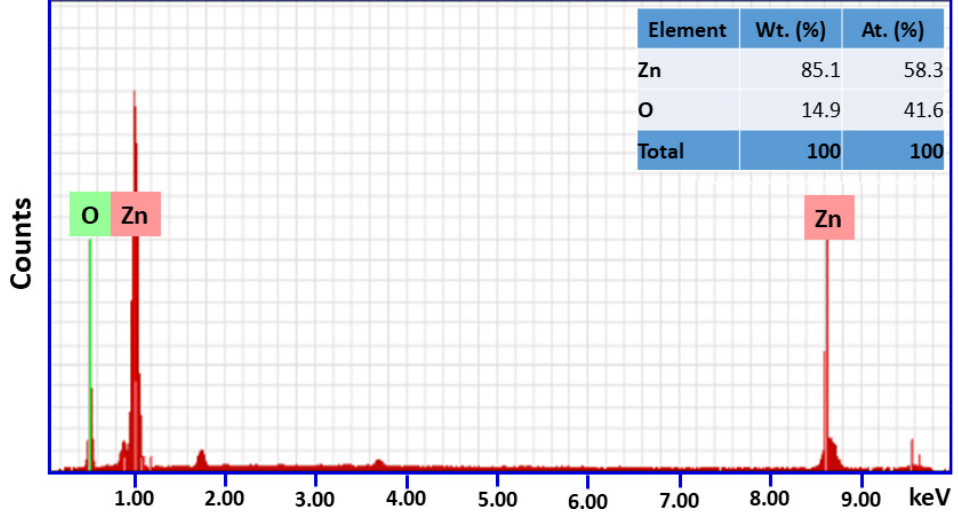
Figure 5. EDAX spectrum of ZnO-GS NPs.